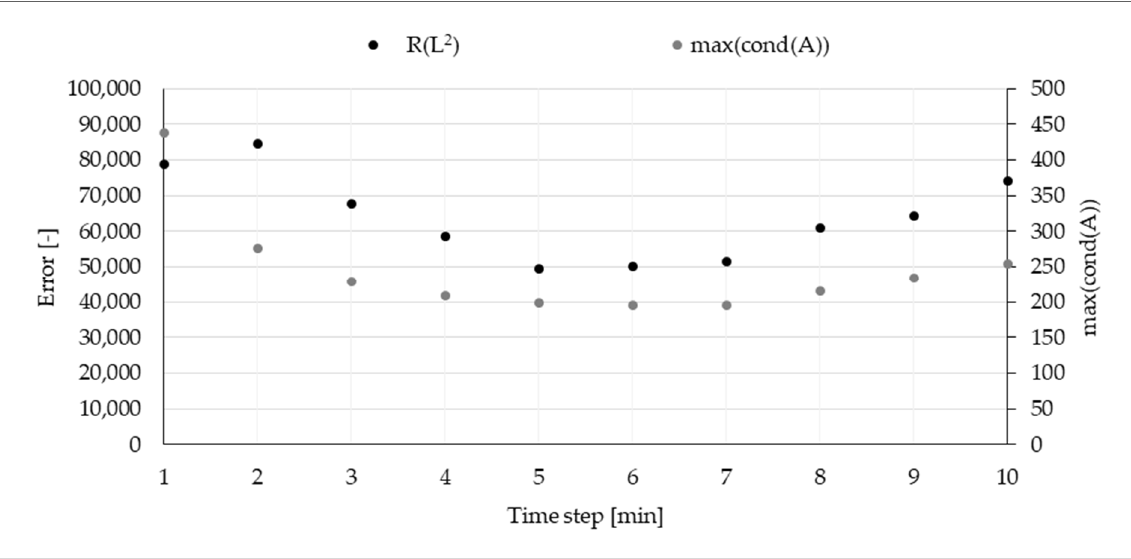
Figure 12. Analysis of the error R ( L 2 ) and maximal conditional value for different longitudes of time step. Comparison of the simulation ( q calc ) and experiment results ( q meas ) were presented only since the stationary heat flow started ( t > 300 min) (Figure 13).